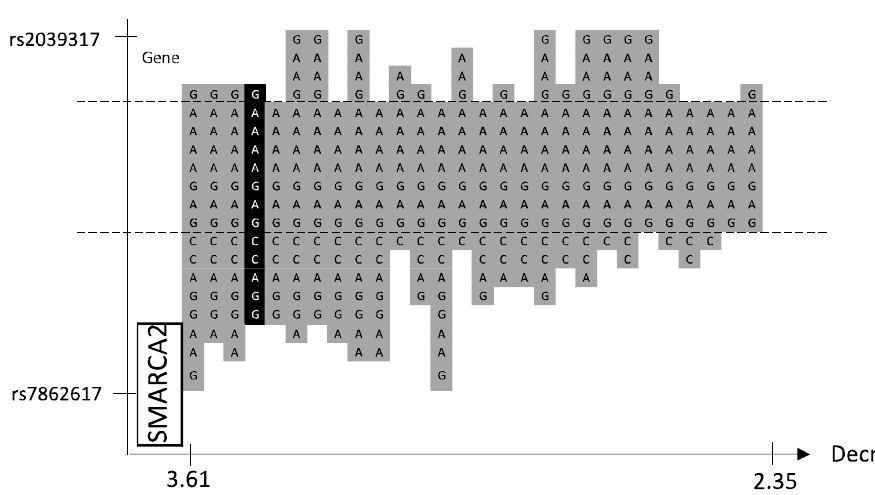
Figure 1. Chromosome 9, 28 significant haplotypes sorted by OR. The haplotype with the lowest p -value is marked in black and other significant haplotypes in gray. SNP position is on the y -axis. Gene position for SMARCA2 is indicated along the y -axis. The corresponding OR is on the x -axis. Because of numerous significant haplotypes in this locus, no borderline significant variants are shown. The dashed lines indicate the proximal and distal SNP that are shared by all significant haplotypes.